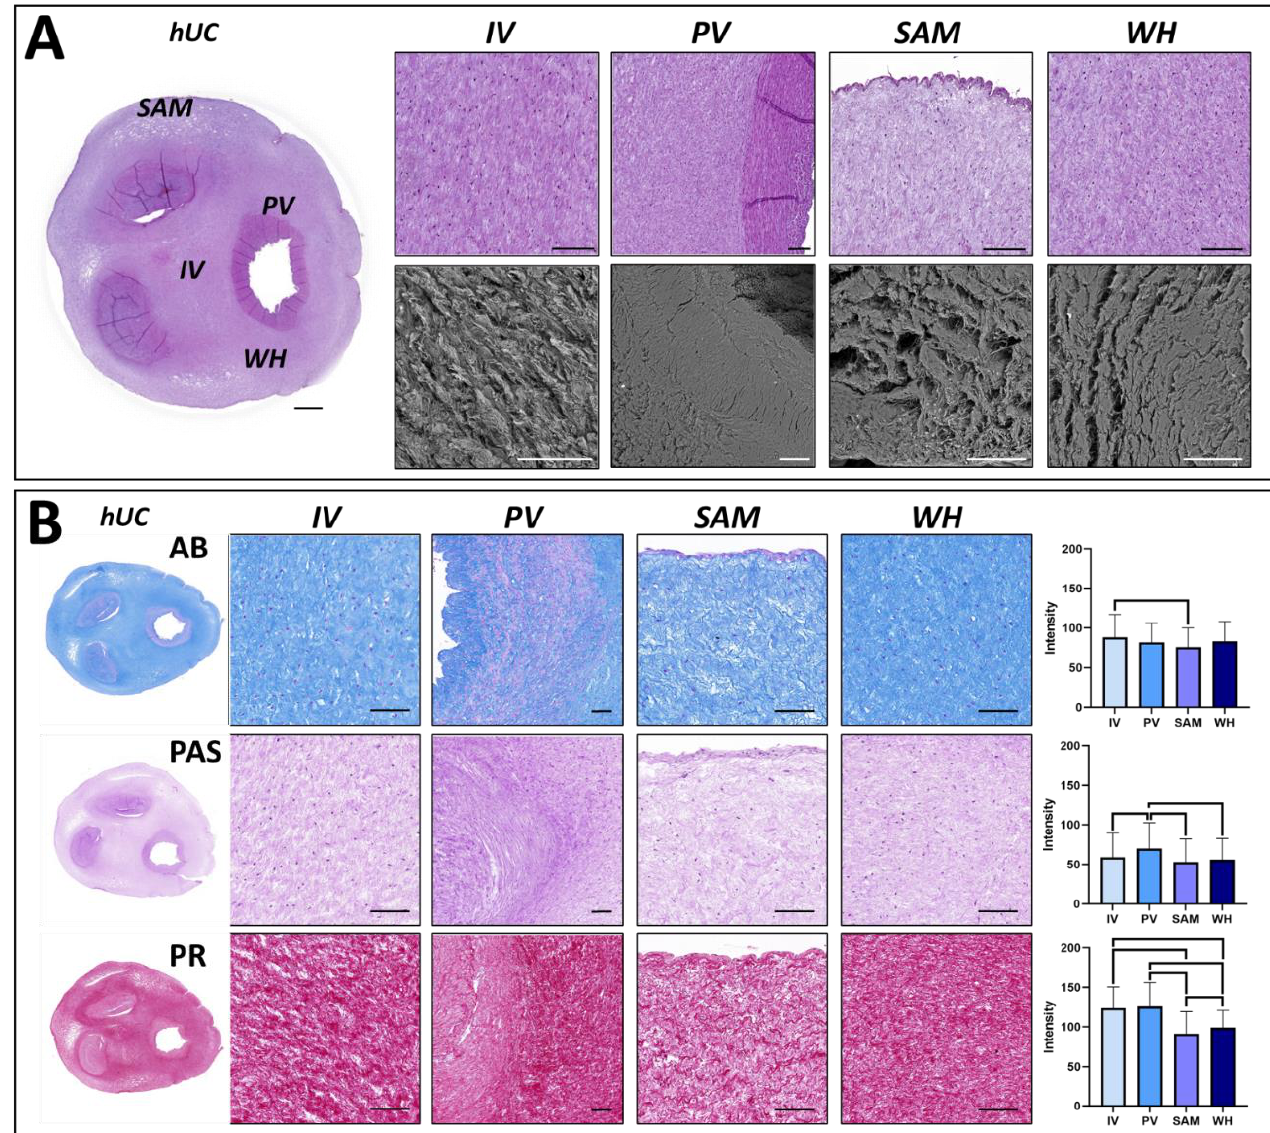
Figure 1. In situ histological (panel ( A )) and histochemical analysis (panel ( B )) of the human umbilical cord (hUC) and its different zones. Samples corresponding to the histological analysis were stained with hematoxylin-eosin (HE) or analyzed by scanning electron microscopy (SEM). Samples analyzed by histochemistry were subjected to alcian blue (AB), periodic acid-Schiff (PAS), and picrosirius red (PR) staining. The histochemical intensity obtained for each sample and each method is shown in the histograms to the right, with statistically significant differences shown as brackets. IV: intervascular zone; PV: perivascular zone; SAM: subamnioblastic zone; WH: Wharton zone. Scale bar = 200 µm.